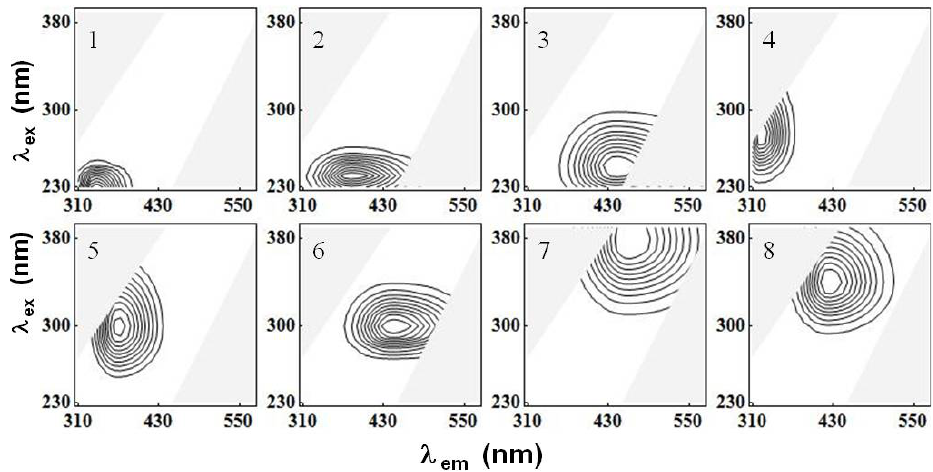
Fig. 4. Shape of the eight peaks individuated in sample S17 after the optimal selection model process illustrated in Fig. 3b (contour plot (ii)). Each contours represents 10% of total intensity.